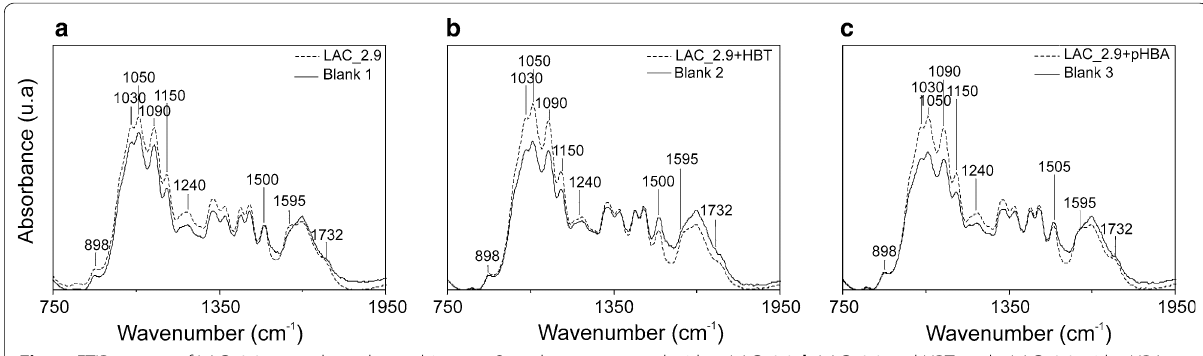
Fig. 4 FTIR spectra of LAC_2.9-treated eucalyptus biomass. Samples were treated with: a LAC_2.9; b LAC_2.9 and HBT; and c LAC_2.9 with p HBA. Dotted lines represent spectra of enzyme-treated samples. Solid lines represent spectra of equivalent no-enzyme controls treated with cellular extract of E.